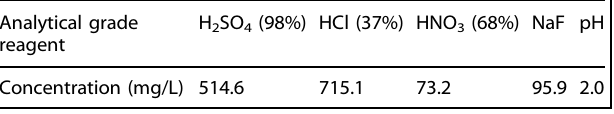
Table 3. Chemical composition of the simulated condensates used in the present work.